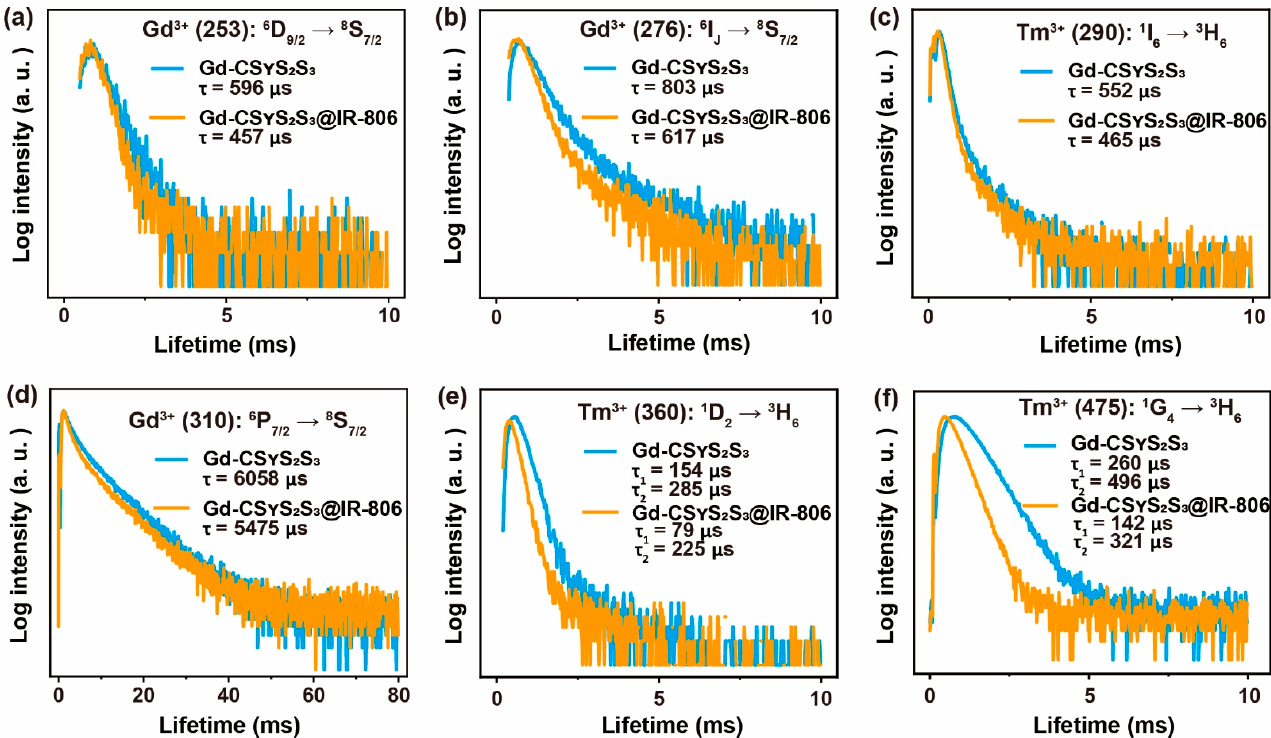
Figure 5. The decreased lifetime of Tm 3+ and Gd 3+ for Gd ‐ CS Y S 2 S 3 @IR ‐ 806. ( a – f ) The Tm 3+ and Gd 3+ lifetime decay curves of Gd ‐ CS Y S 2 S 3 and Gd ‐ CS Y S 2 S 3 @IR ‐ 806 at 253, 276, 290, 310, 360, and 475 nm under 808 nm excitation, respectively. of Gd-CS Y S 2 S 3 and Gd-CS Y S 2 S 3 @IR-806 at 253, 276, 290, 310, 360, and 475 nm under 808 nm excitation,